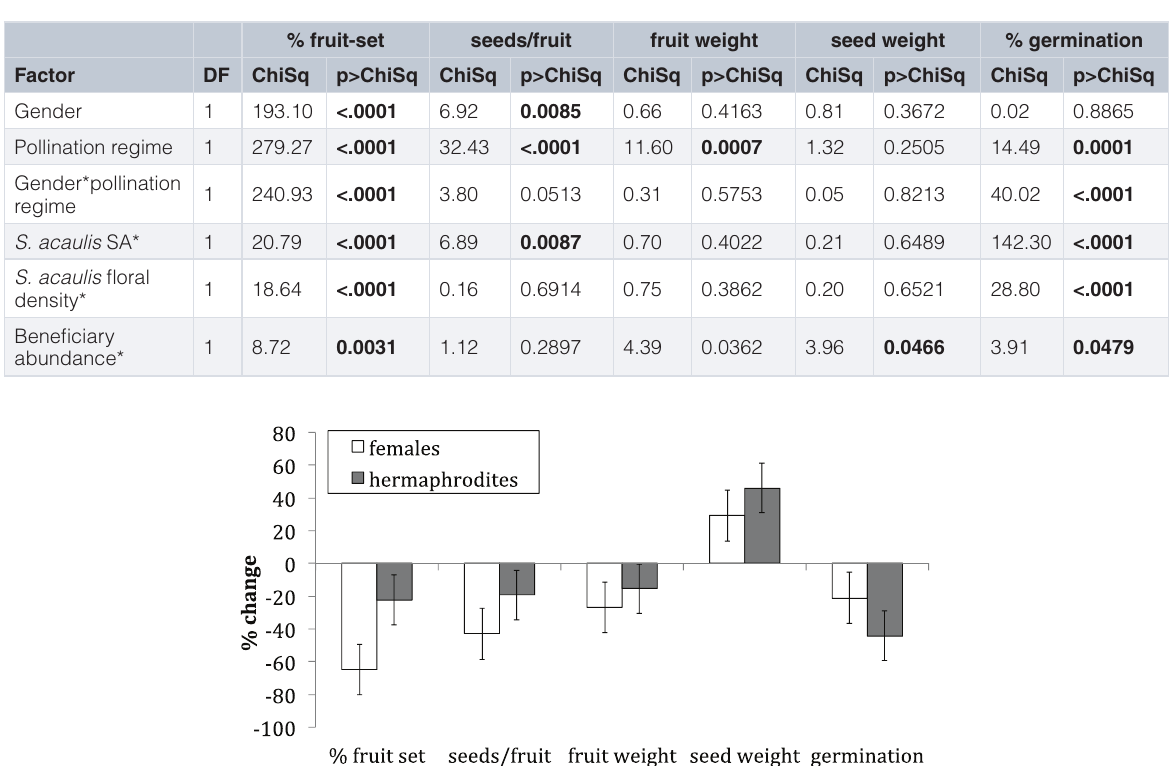
Figure 1. Percent change of female (white) and hermaphrodite (grey) reproductive output measures between current and reduced pollination regimes. ± 1 standard error bars